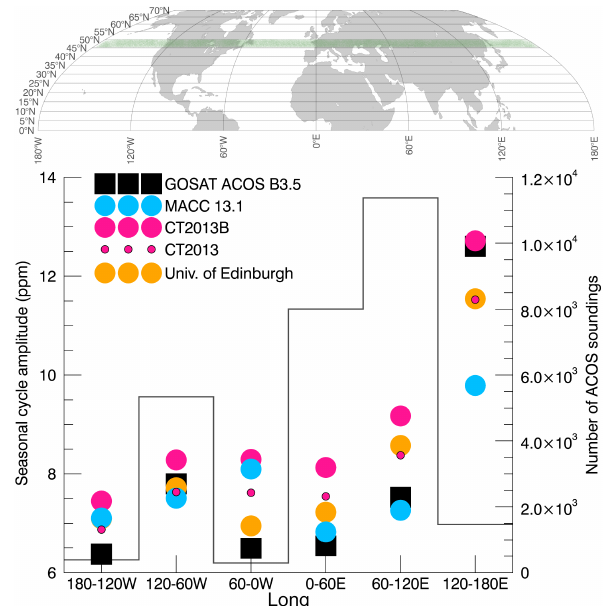
Figure 8. Longitudinal dependence of the seasonal cycle amplitude within the latitude band 45–50 ◦ N. The left vertical axis shows the seasonal cycle amplitude in ppm, while the right vertical axis indi- cates the number of soundings that fall within each 60 ◦ longitude bin. This latitude zone is highlighted in the world map where also the locations of the continents can be